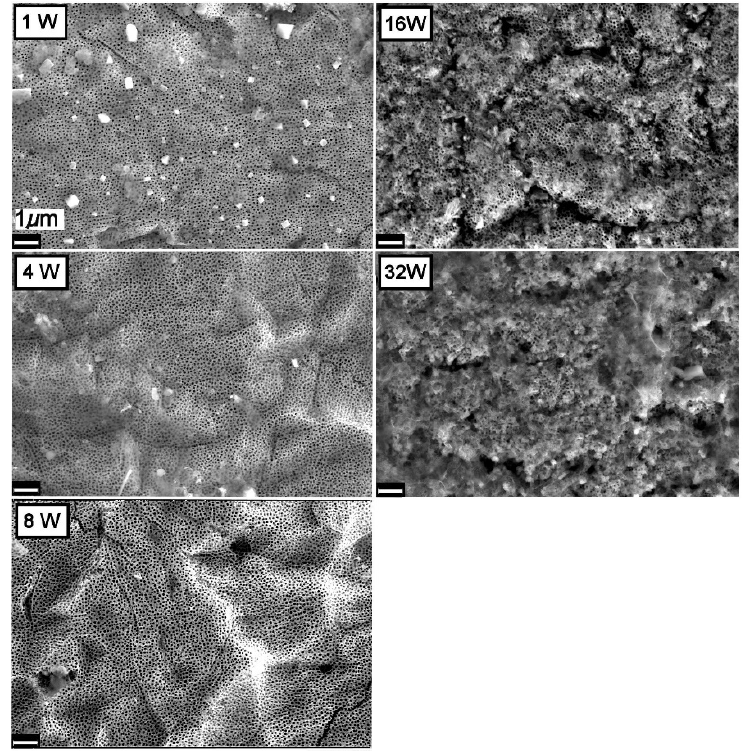
Figure 6. Changes observed on the surface of the TiO 2 NT-Ag sample when exposed to synthetic greywater under atmospheric conditions.